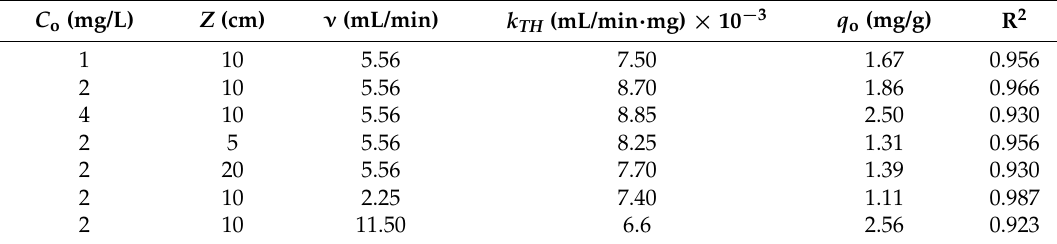
Table 6. Thomas model parameters for EE2 adsorption onto PMPS particles.